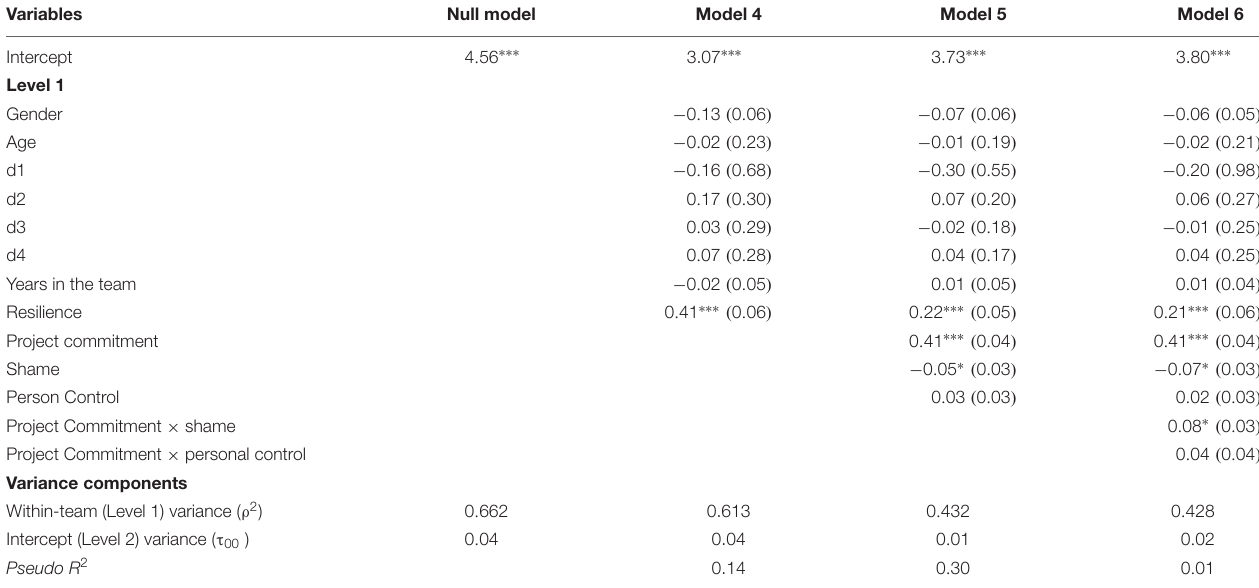
TABLE 4 | Multilevel estimates for models.